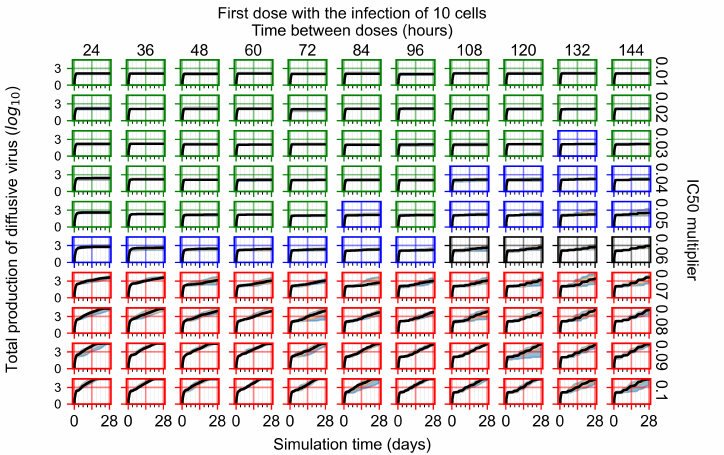
Figure A10. Total diffusive virus produced (AUC), Y axis in log scale, and exponent values as tick